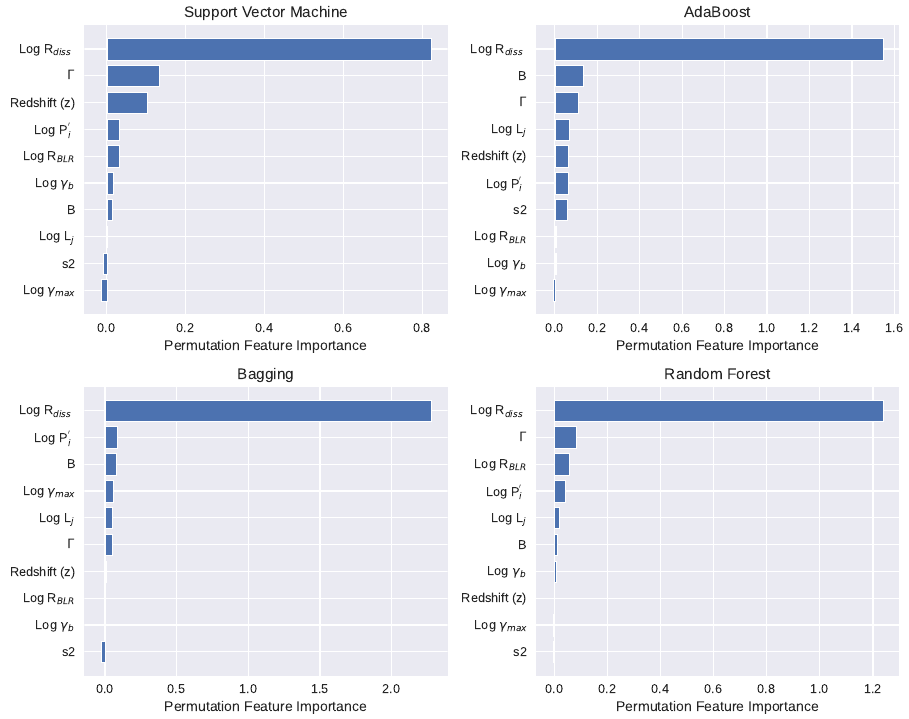
Figure 5. Relative importance of various input parameters for different machine learning